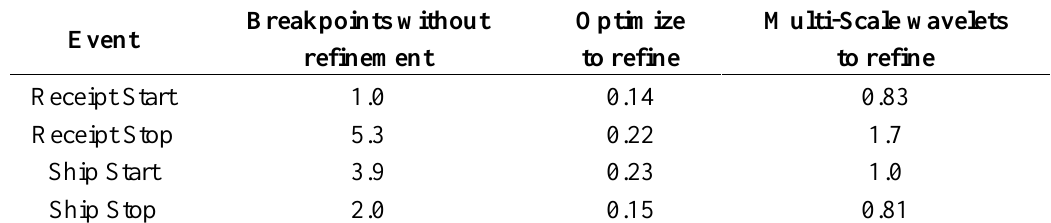
Table 1. The root mean squared errors (RMSEs) for change point detection with and without refinement using the optimize function using 10 4